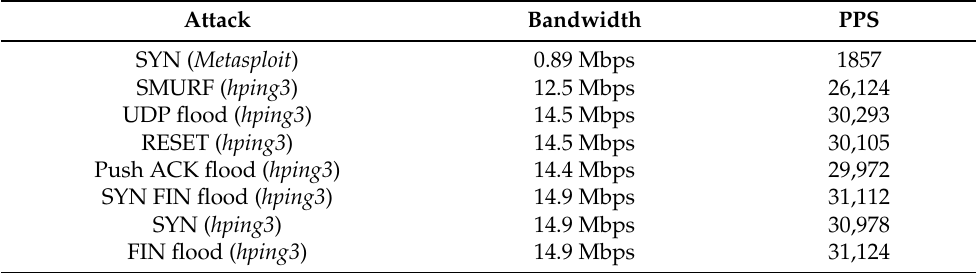
Table 3. Attacker’s brute force output.